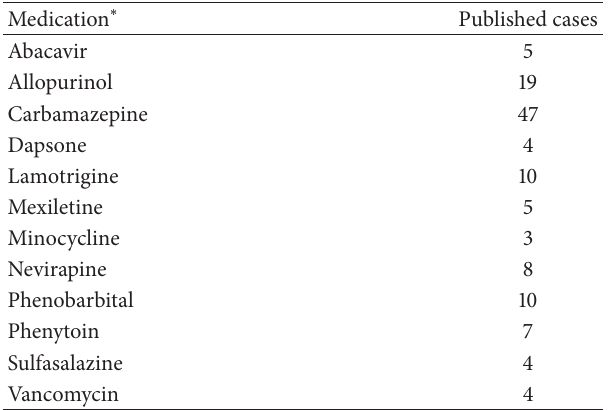
Table 2: Published case reports related to drug reaction with eosinophilia and systemic symptoms